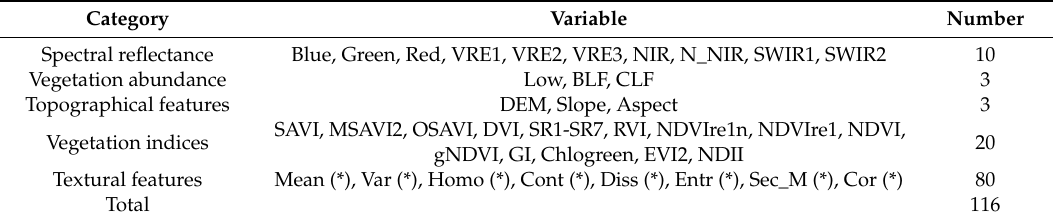
Table 2. Candidate variables for biomass